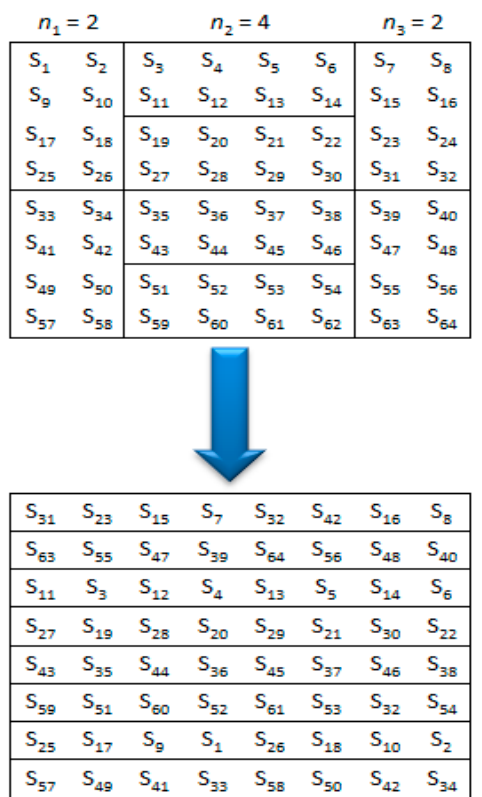
Figure 4. Discretized Baker map operation with N =